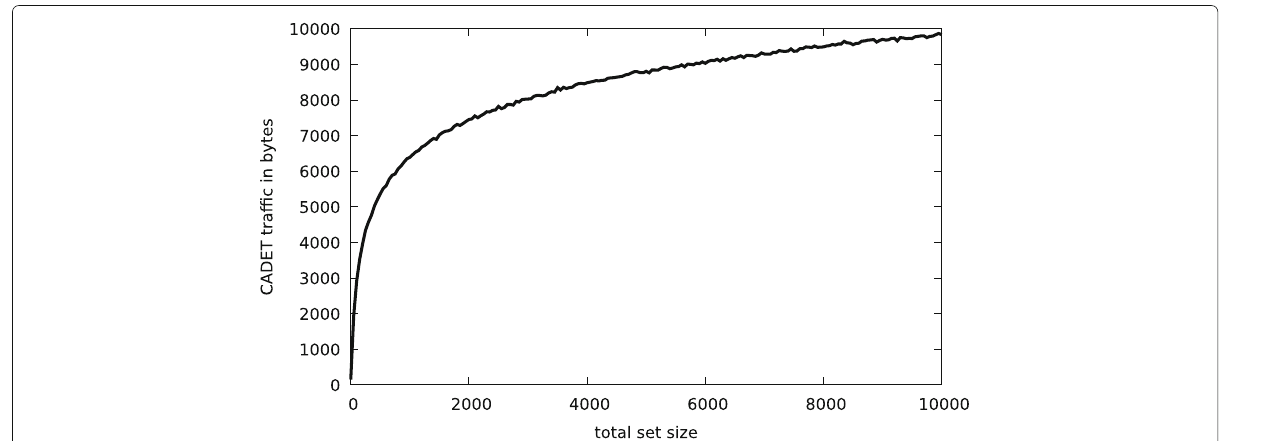
Fig. 2 CADET traffic for the SET service in relation to total set size. Average over 50 executions